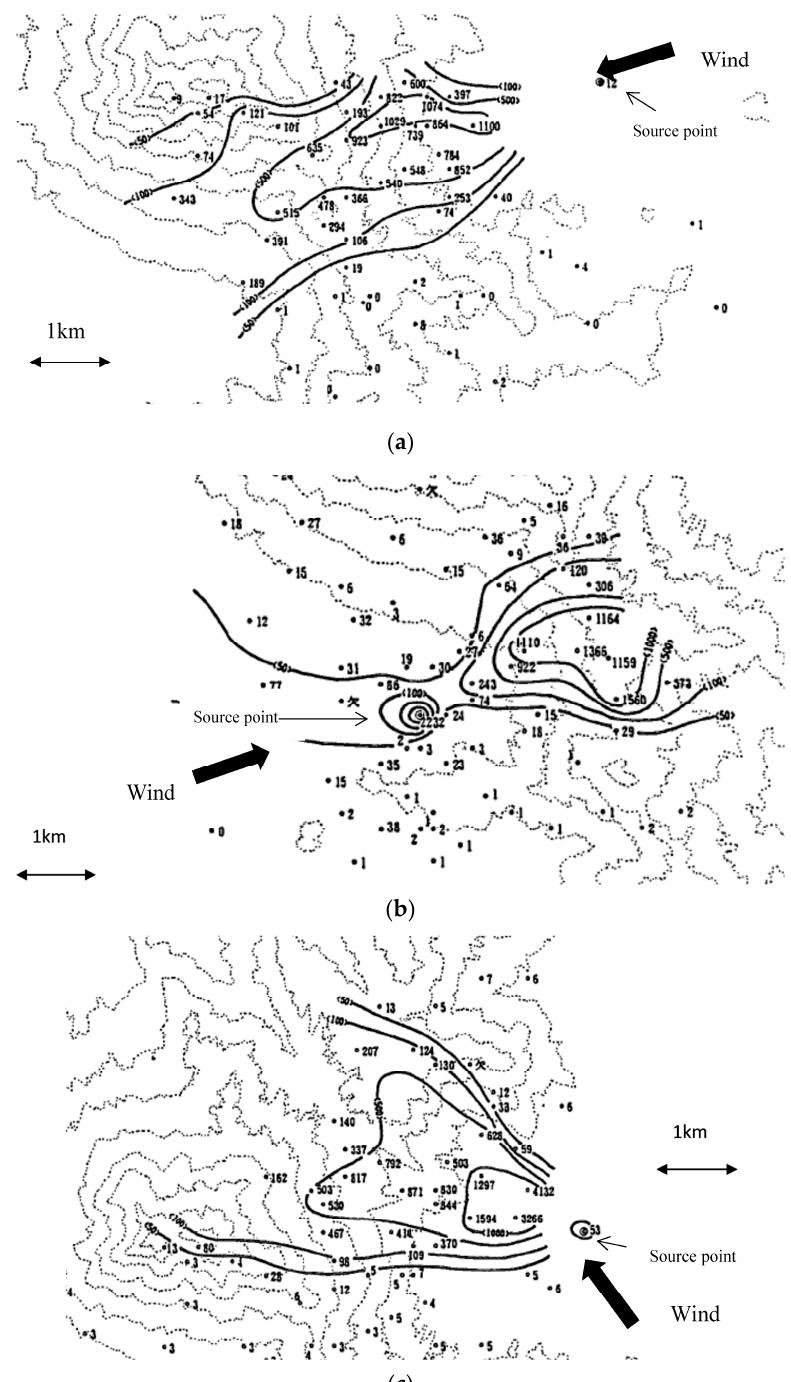
Figure 4. Contour map of 30 min averaged ground level concentrations (ppt) [4]. ( a ) Run No. 89-3 (D); ( b ) Run No. 90-5 (F); ( c ) Run No. 90-8 (B).